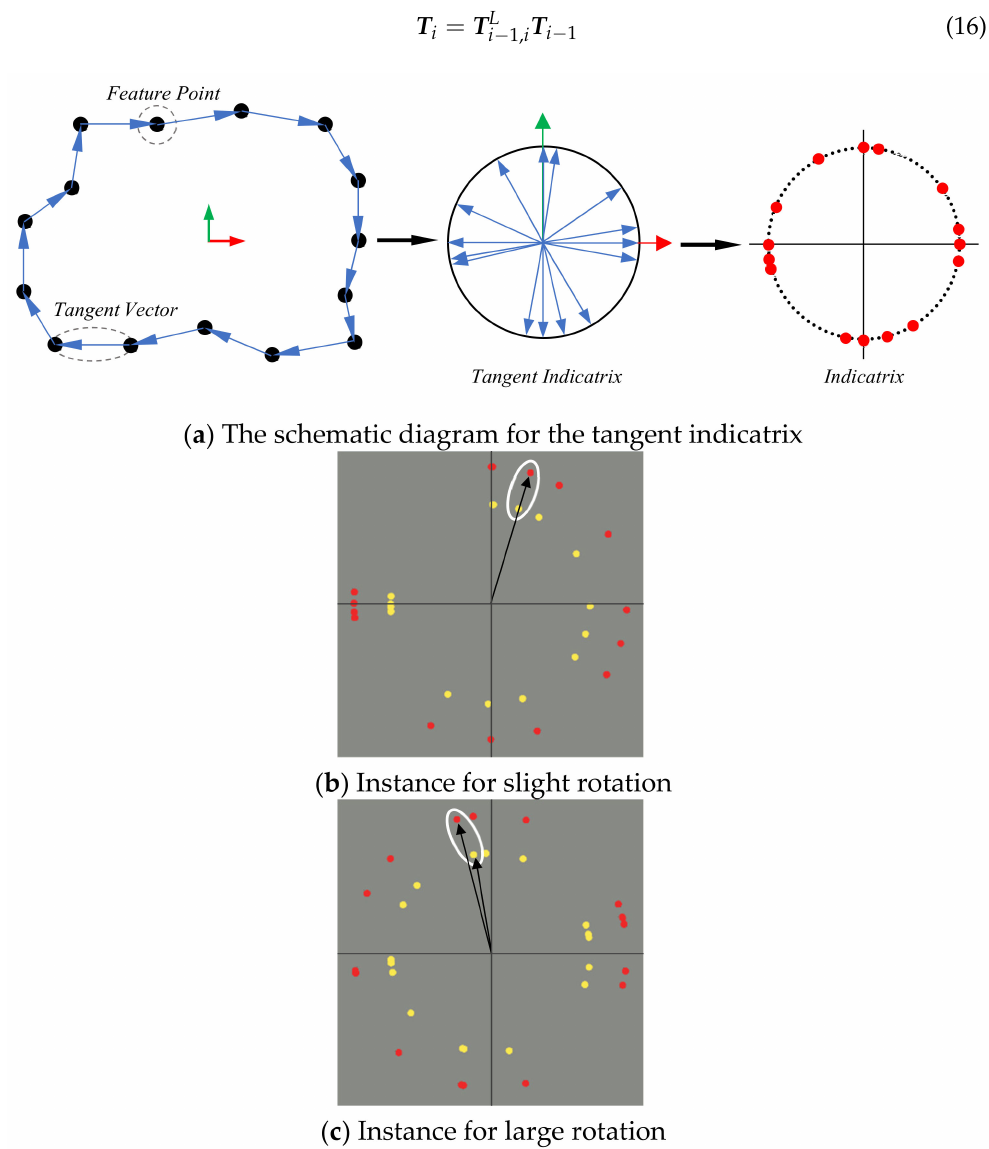
Figure 5. The illustration of the tangent-vector pair for steadily solving rotation DoF. ( a ) Left shows an example when the tangent vector is computed by two points, so the tangent vector is end-to- end. ( b ) The tangent-vector pair is in the white ellipse, the angular deviation of the vector pair is 0.63 degrees, and the average angle deviation of all the vector pairs is 0.98 degrees. The sensor is almost not rotating. ( c ) In the white ellipse, the angular deviation of the vector pair is 4.52 degrees, and the average angle deviation of all vector pairs is 3.80 degrees. The sensor is